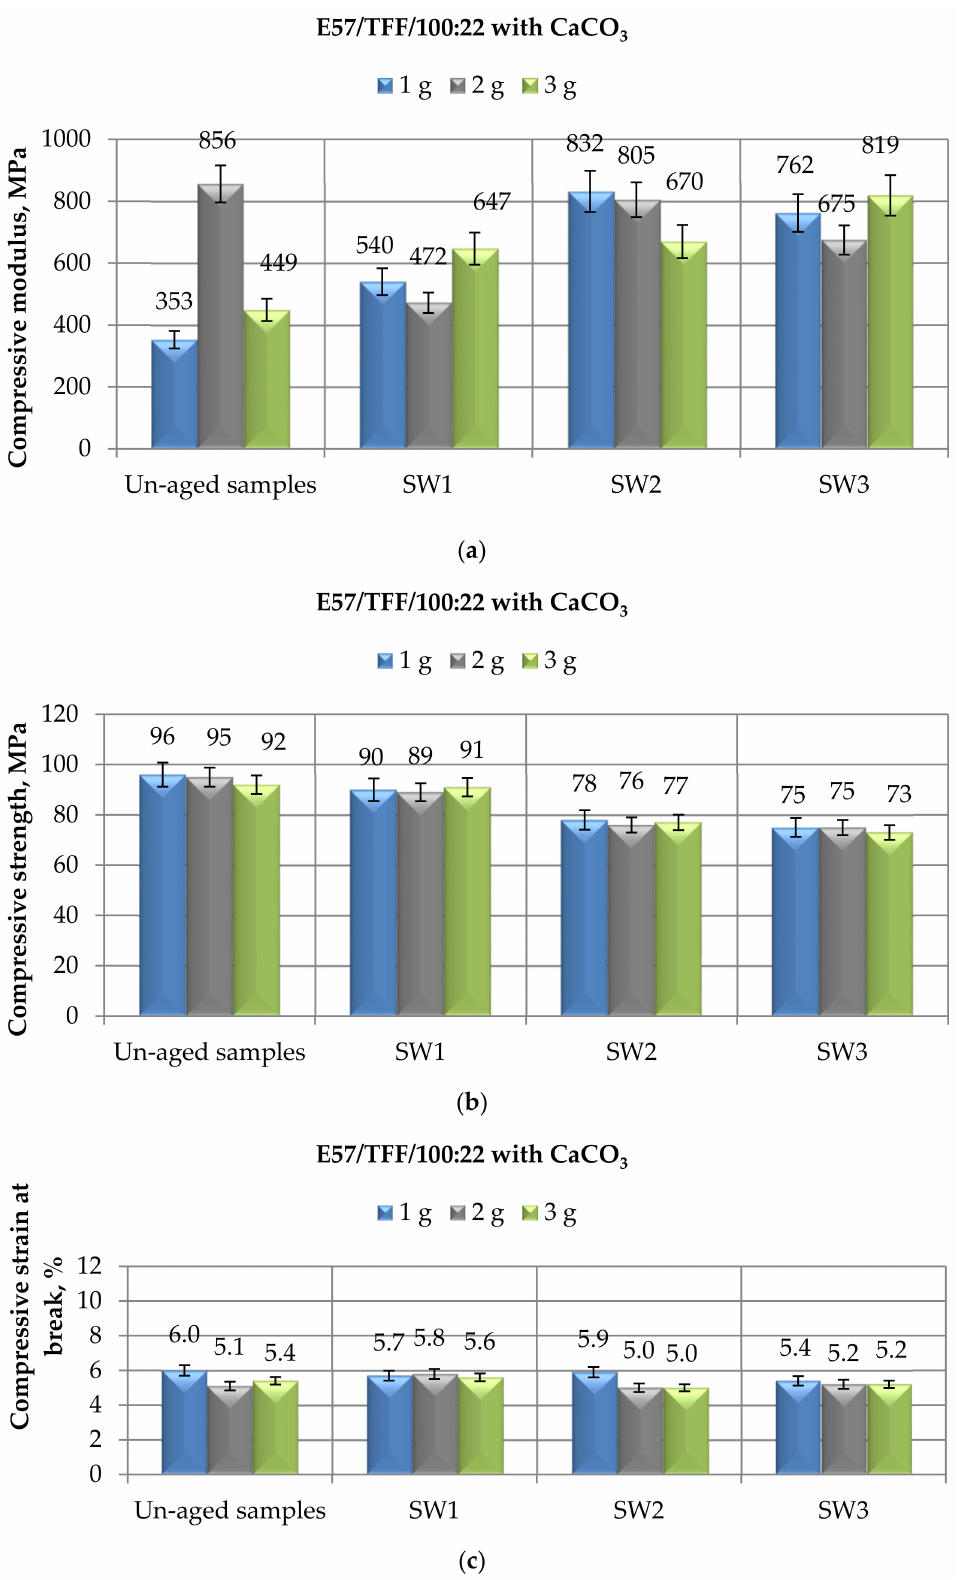
Figure 5. Results of mechanical tests performed in compression mode on CaCO 3 -filled E57/TFF/100:22 specimens after different immersion times (i.e., 1, 6, and 10 months) in spring water, in terms of ( a ) Compressive modulus; ( b ) Compressive maximum strength; ( c ) Compressive strain at